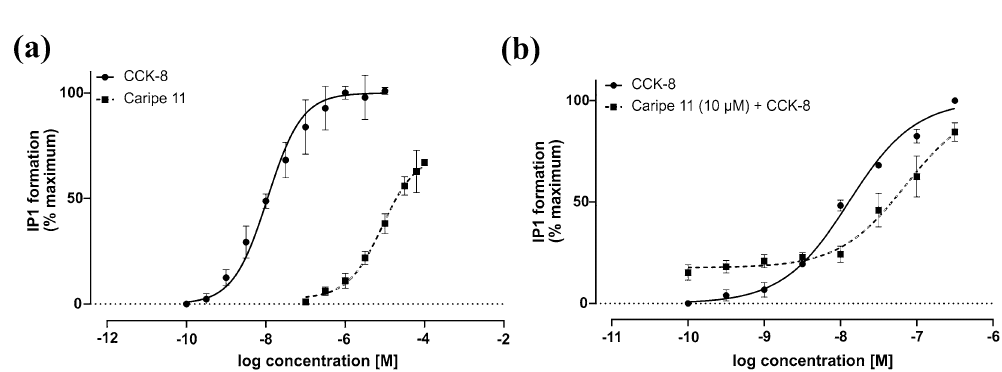
Figure 5. Partial agonist activity of caripe 11 at the CCK 2 R. ( a ) Concentration–response curves of the effect of CCK-8 and caripe 11 upon activation of the receptor via measurement of the intracellular formation of IP1. Potency and efficacy values are listed in Table 2. ( b ) Concentration–response curves of CCK-8 alone and in combination with caripe 11 (10 µM). Stimulation buffer and CCK-8 peptide were used as negative and positive controls with 0 and 100% efficacy, respectively. Each experiment was carried out in technical triplicate and three (n = 3) biological repeats. All data are shown as mean ±